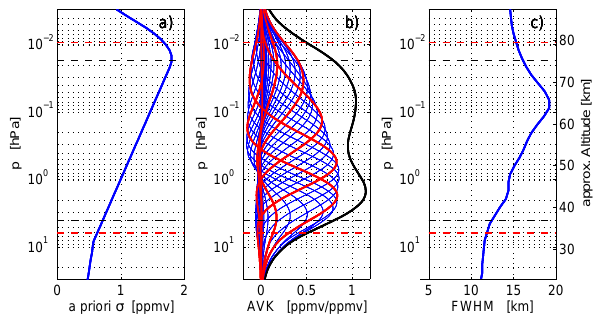
Fig. 3. (a) A priori standard deviation used for both MIAWARA-C and MIAWARA (square root of diagonal elements of S a ). (b) Aver- aging kernels multiplied by 5 for MIAWARA-C with a noise level of 0.014K (blue); highlighted in red are the averaging kernel belong- ing to approximately 30, 40, 50, 60, 70 and 80km. The black line shows the area of the averaging kernels (AoA) used as a measure for the sensitive altitude range of this retrieval version. (c) FWHM of the averaging kernel as a measure of vertical resolution. The red and black dashed lines indicate the altitude range with AoA > 0.5 and AoA > 0.8, respectively. AoA > 0.8 is used as an upper and lower limit of this retrieval